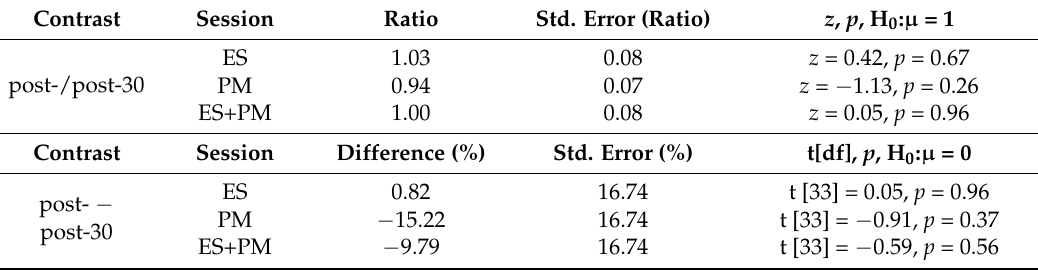
Table 5. Contrasts across time and their standard errors estimated from the statistical